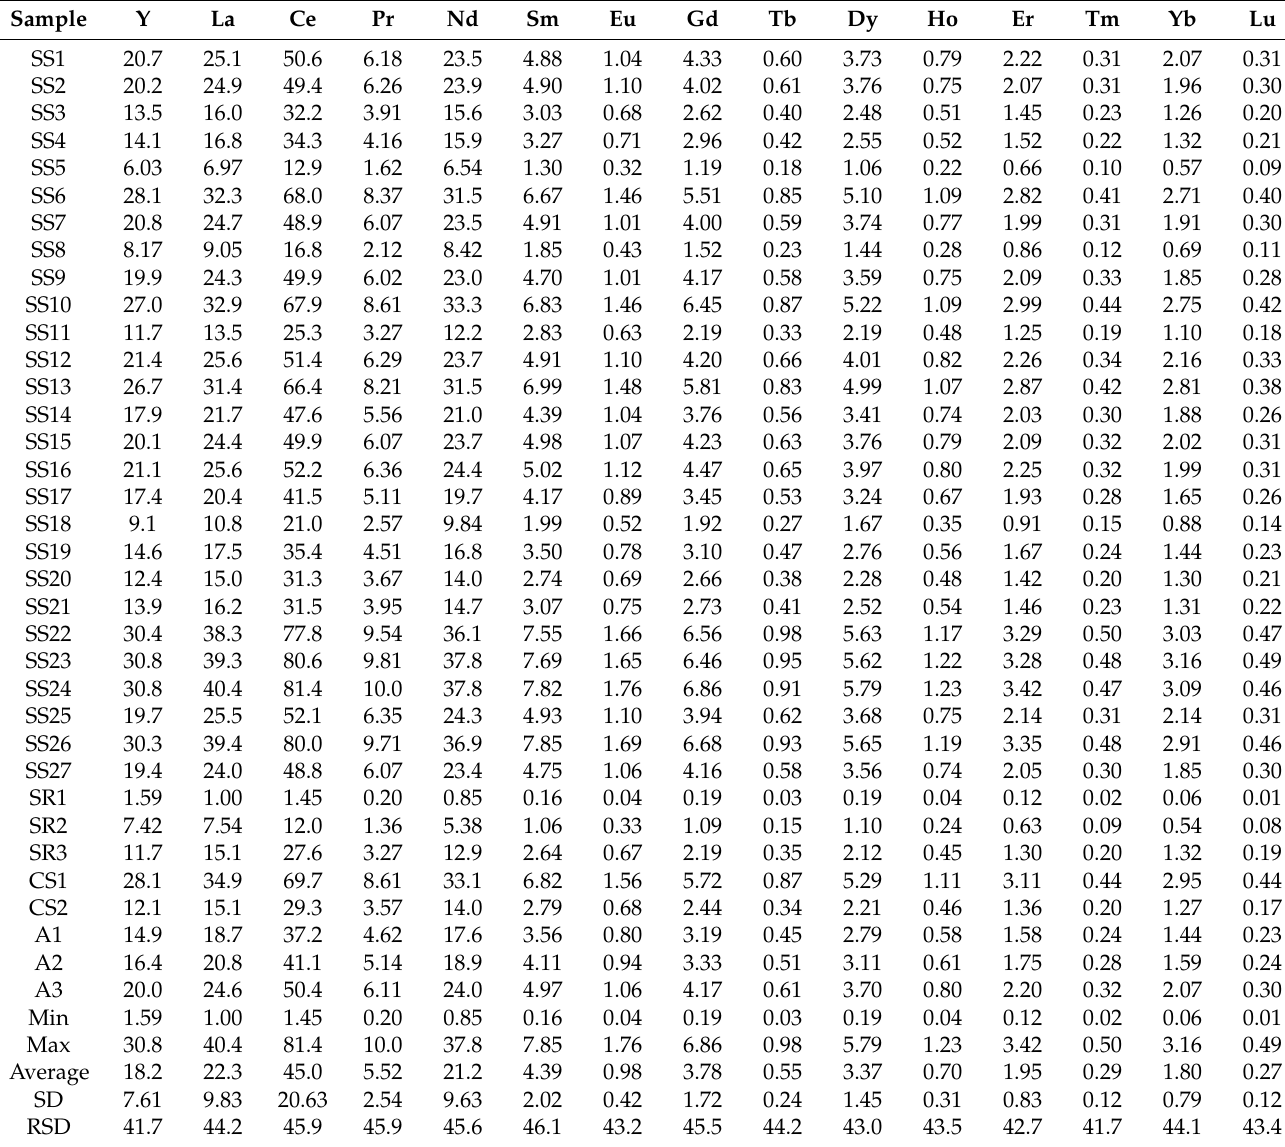
Table 5. Rare earth element composition (in mg kg − 1 ) of the studied